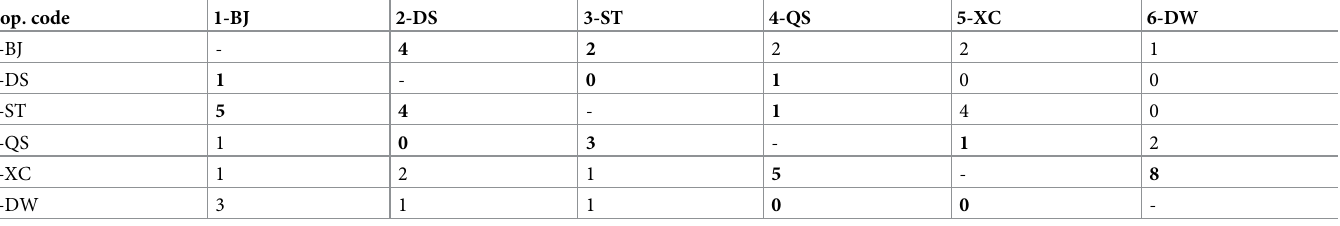
The numbers of migrants between adjacent populations are highlighted in